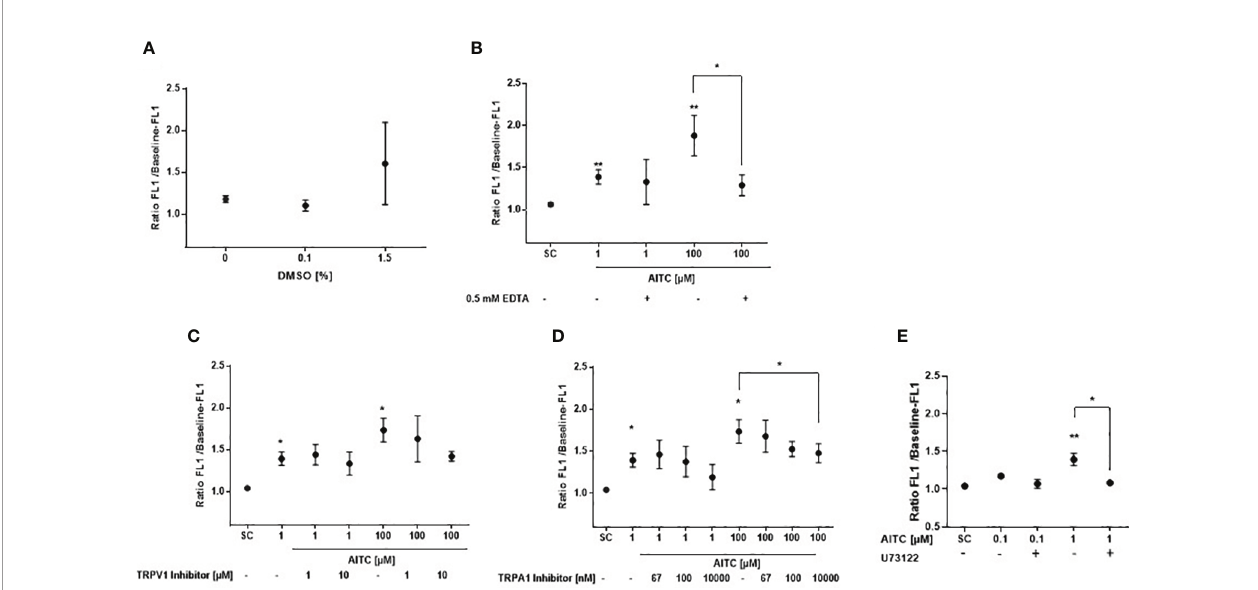
FIGURE 2 | Speci fi city of T2R38 receptor activation by AITC. PBMC were isolated from PAV/PAV genotype subjects and exposed to (A) DMSO or were (B) pre- treated with/without 0.5 mM EDTA for 5 min, (C) the TRPV1 antagonist capsazepine (CPZ) for 30 min, (D) the TRPA1 antagonist A-967079 for 30 min, and (E) the PLC- b 2 antagonist U73122 for 30 min before AITC exposure. FACS based measurement of calcium fl ux was then detected in the monocyte subpopulation probed with Fluor-4 AM (F EM:516 nm ). Baseline fl uorescence was recorded for 60 sec. After compound exposure, fl uorescence was measured for another 740 sec. Calcium response was calculated as the ratio of the maximum peak post stimulation to basal level using FlowJo software. Dots represent mean values ± SD, n ≥ 3. Signi fi cance of difference was determined using the paired t-test compared to the respective solvent control (SC, 0.1% DMSO), *p<0.05, **p<0.01